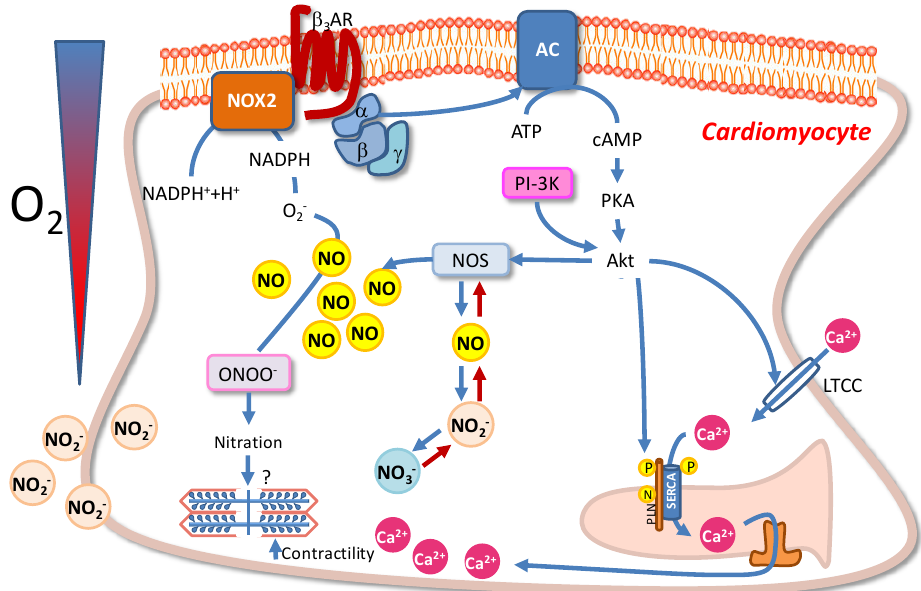
Figure 2. Schematic overview of the NOS/NO-mediated intracellular pathways activated in goldfish cardiomyocytes under hypoxic stress. For details, see the text.